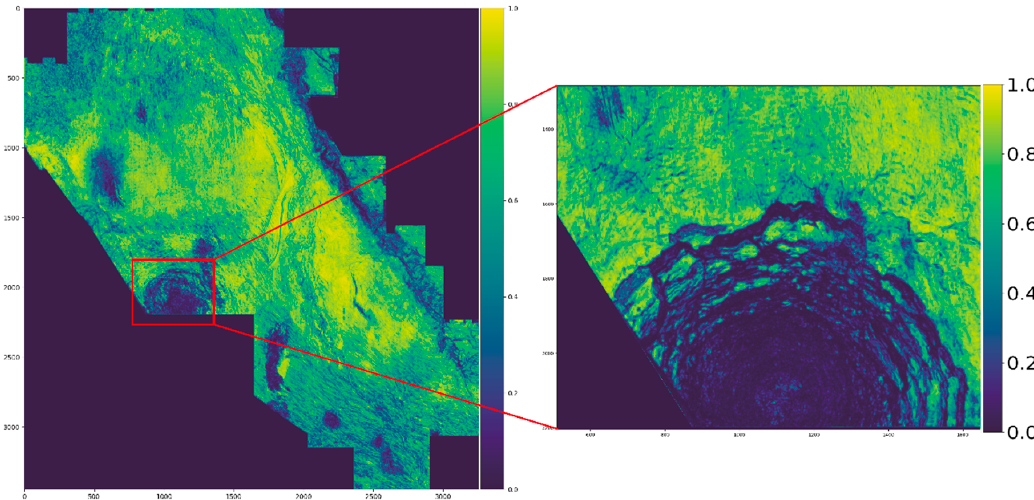
Figure 6. The coherence values of the collapse diapir in the study area.